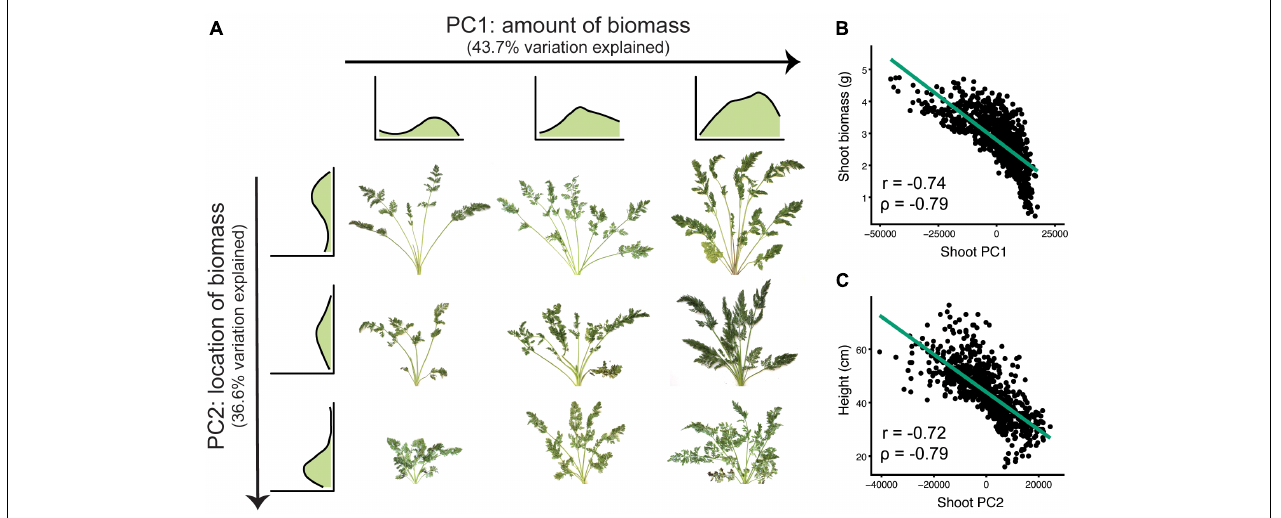
FIGURE 5 | Principal components analysis for shoot biomass profiles ( n = 917 individuals). (A) The first two principal components (PC1 and PC2) detect variation for the magnitude and location of carrot shoot biomass, respectively. Shoot biomass profiles are shown for the top three and leftmost three images. From left to right, sweeping PC1 primarily reflected the amount of biomass (43.7% variation explained). From top to bottom, sweeping PC2 reflected where the biomass was distributed (i.e., petiole length) (36.6% variation explained). (B) Correlation of shoot PC1 with biomass ( P ≤ 0.001). (C) Correlation of shoot PC2 with shoot height ( P ≤ 0.001).